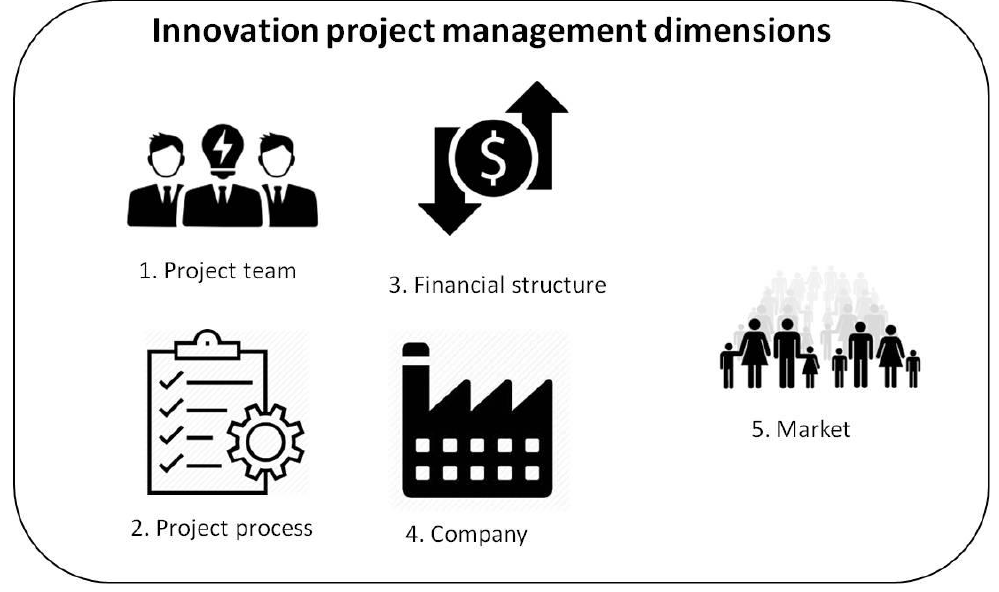
Figure 1. Dimensions of innovation project management (Boly et al. 2015; Claire et al. 2014).